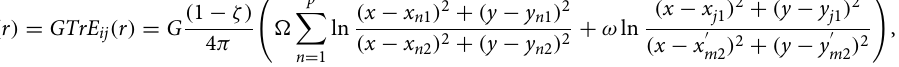
Figure 1. Illustrative examples of GBs with different misorientation angles: ( a ) θ 0.846 nm; ( b ) θ h = 1.01 h =